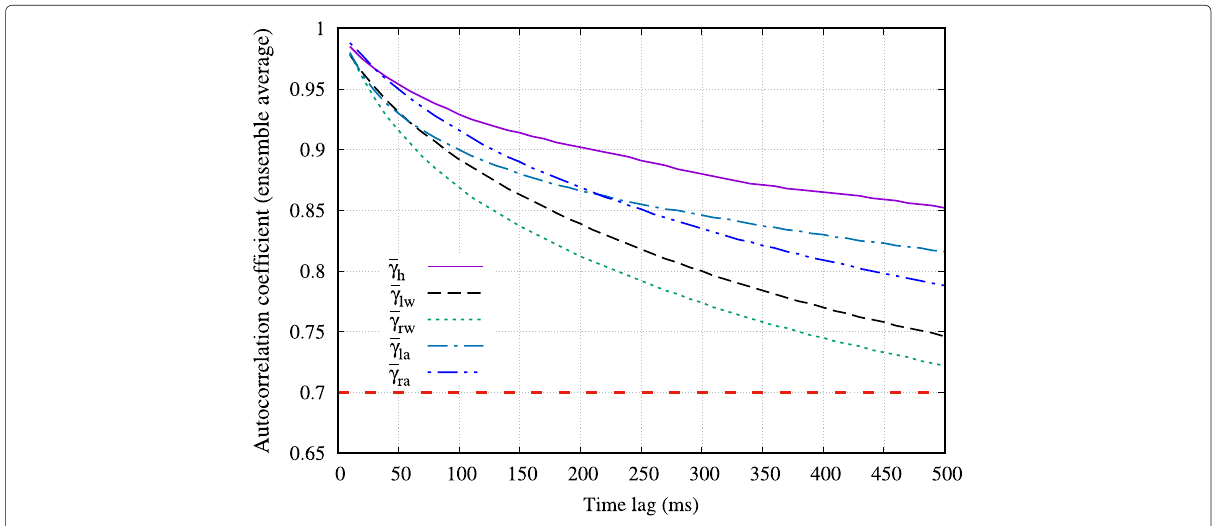
Fig. 5 Ensemble average autocorrelation vs. time